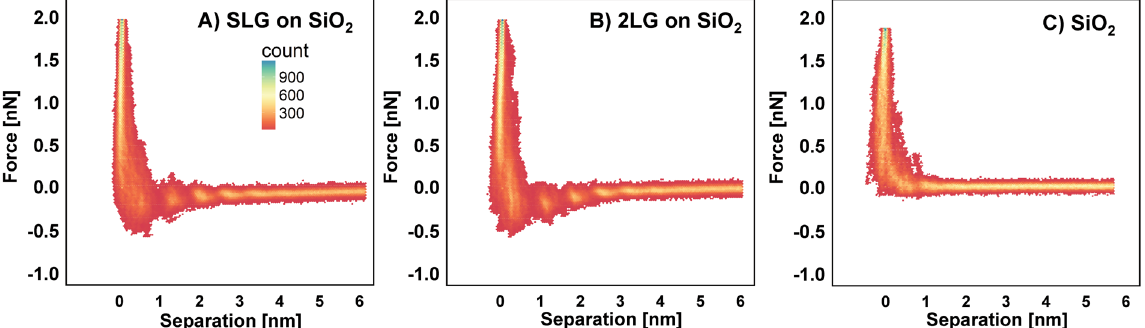
Figure 1. Bivariate histograms for the normal force as a function of the separation (with arbitrary zero at the hard wall at 10 nN) for SLG ( A ), 2LG ( B ), and silica substrate ( C ). FLG is in the SM (Figure S2). The bivariate histograms for the force-separation curves were constructed via hexagonal binning, with a bin size of 150. Red highlights regions of low data density, whereas yellow regions highlight regions of high data density. Due to the inherent uncertainty of the absolute tip-substrate separation in AFM force measurements, we note that the abscissa has an arbitrary zero but we label it as “separation”. Figure S1 shows AFM images of the graphene sample and the corresponding Raman spectra. Spring constant of cantilever = 0.3507 N/m and Si-tip with radius = 35